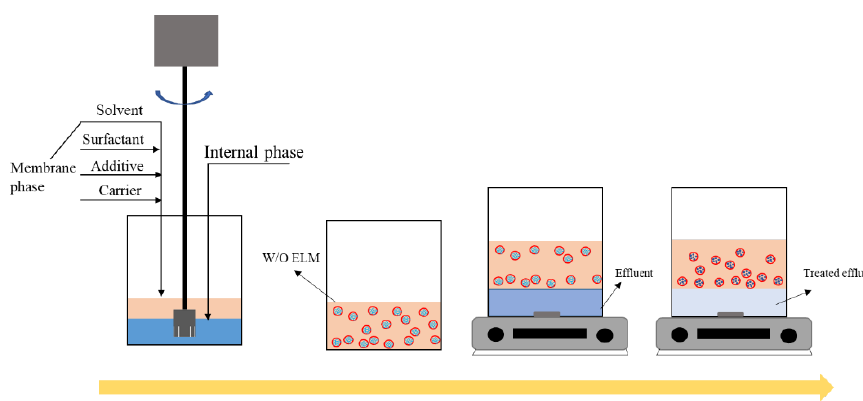
Figure 2. Flow chart of the separation experiment of emulsion liquid membrane production. Table 1. Properties of waste